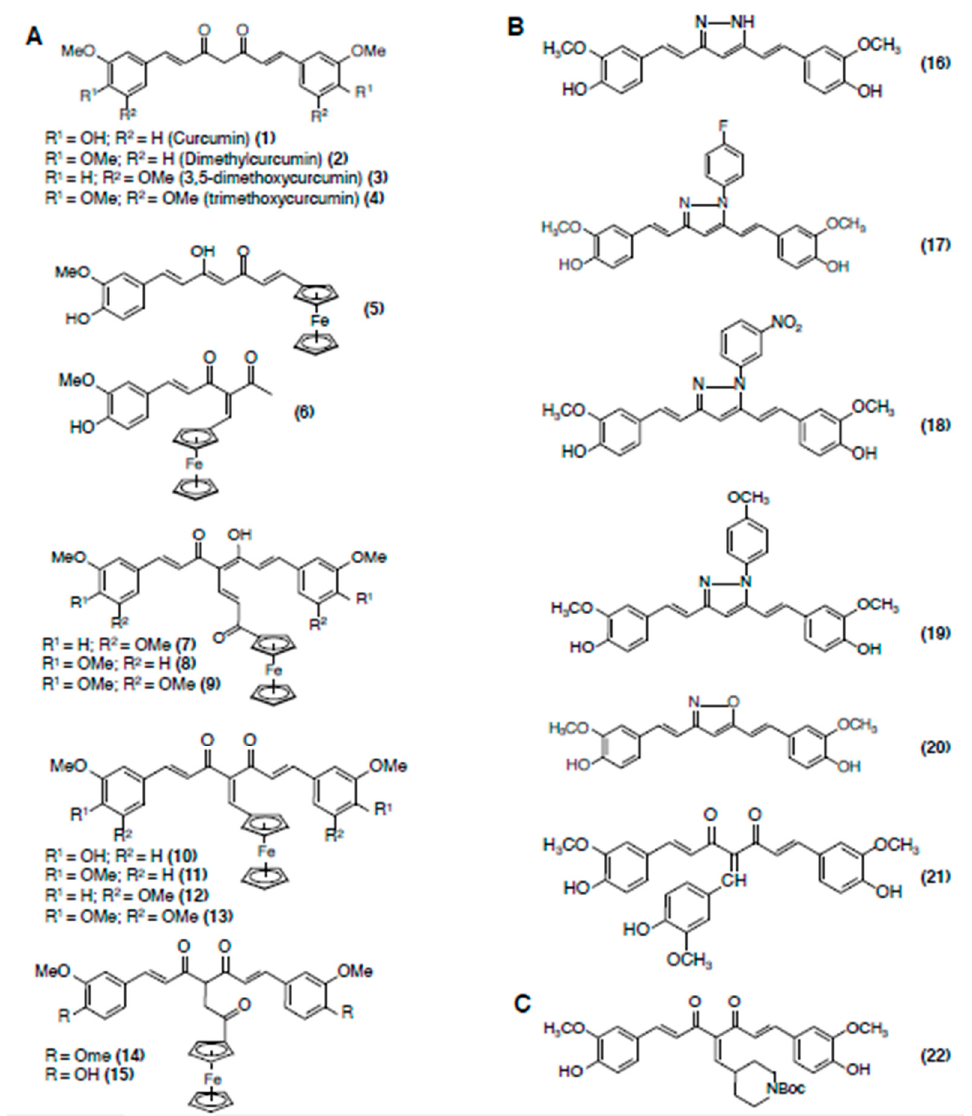
Figure 4. Chemical structures of curcumin and curcumin analogs. ( A ) Ferrocenyl curcumin derivatives. ( B ) Pyrazole, isoxazole, and benzylidiene derivatives of curcumin. ( C ) A highly potent curcumin derivative, named C1 ( 22 ).